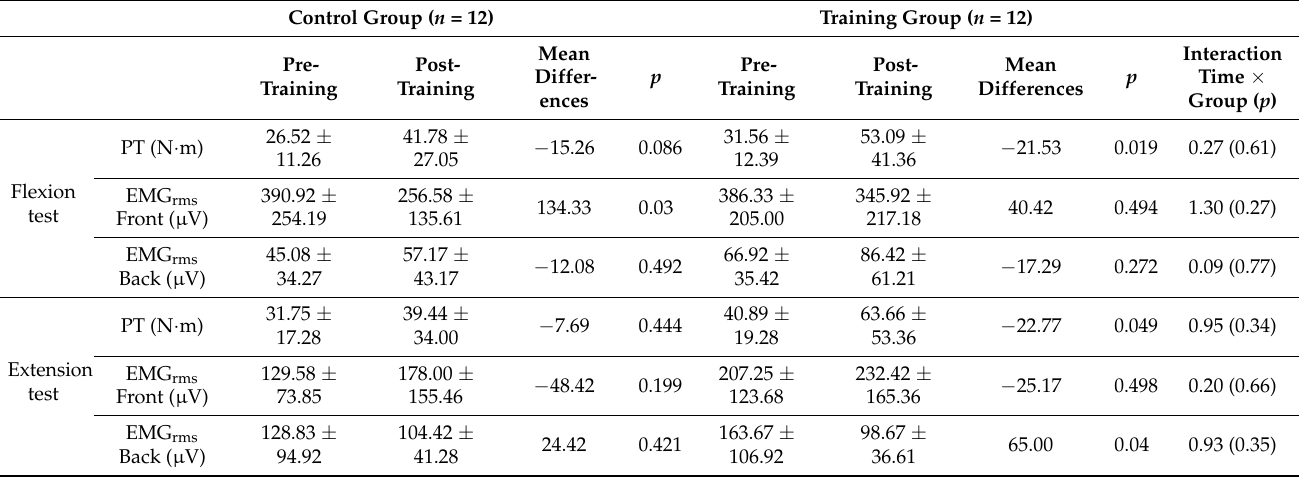
Table 4. Performance in isometric test and electromyography